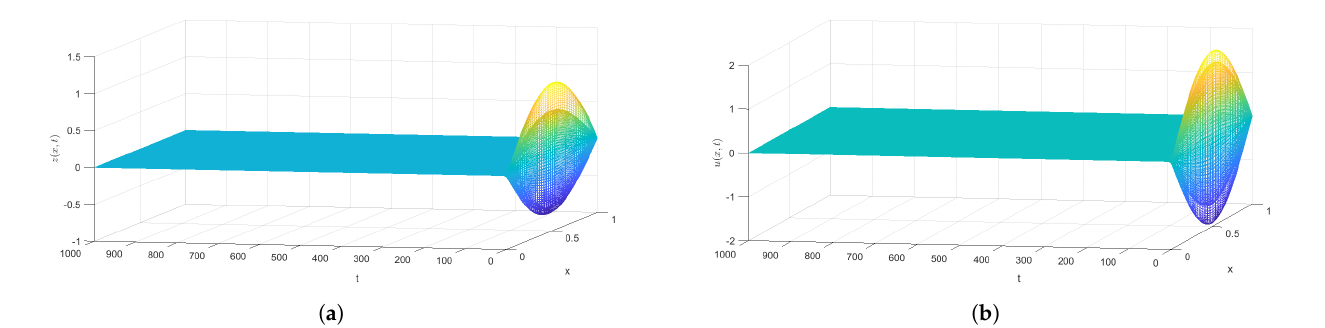
Figure 5. Test 3: The approximate solution ( z , u ) in the x - t plane. ( a ) z ( x , t ) . ( b ) u ( x , t ) .